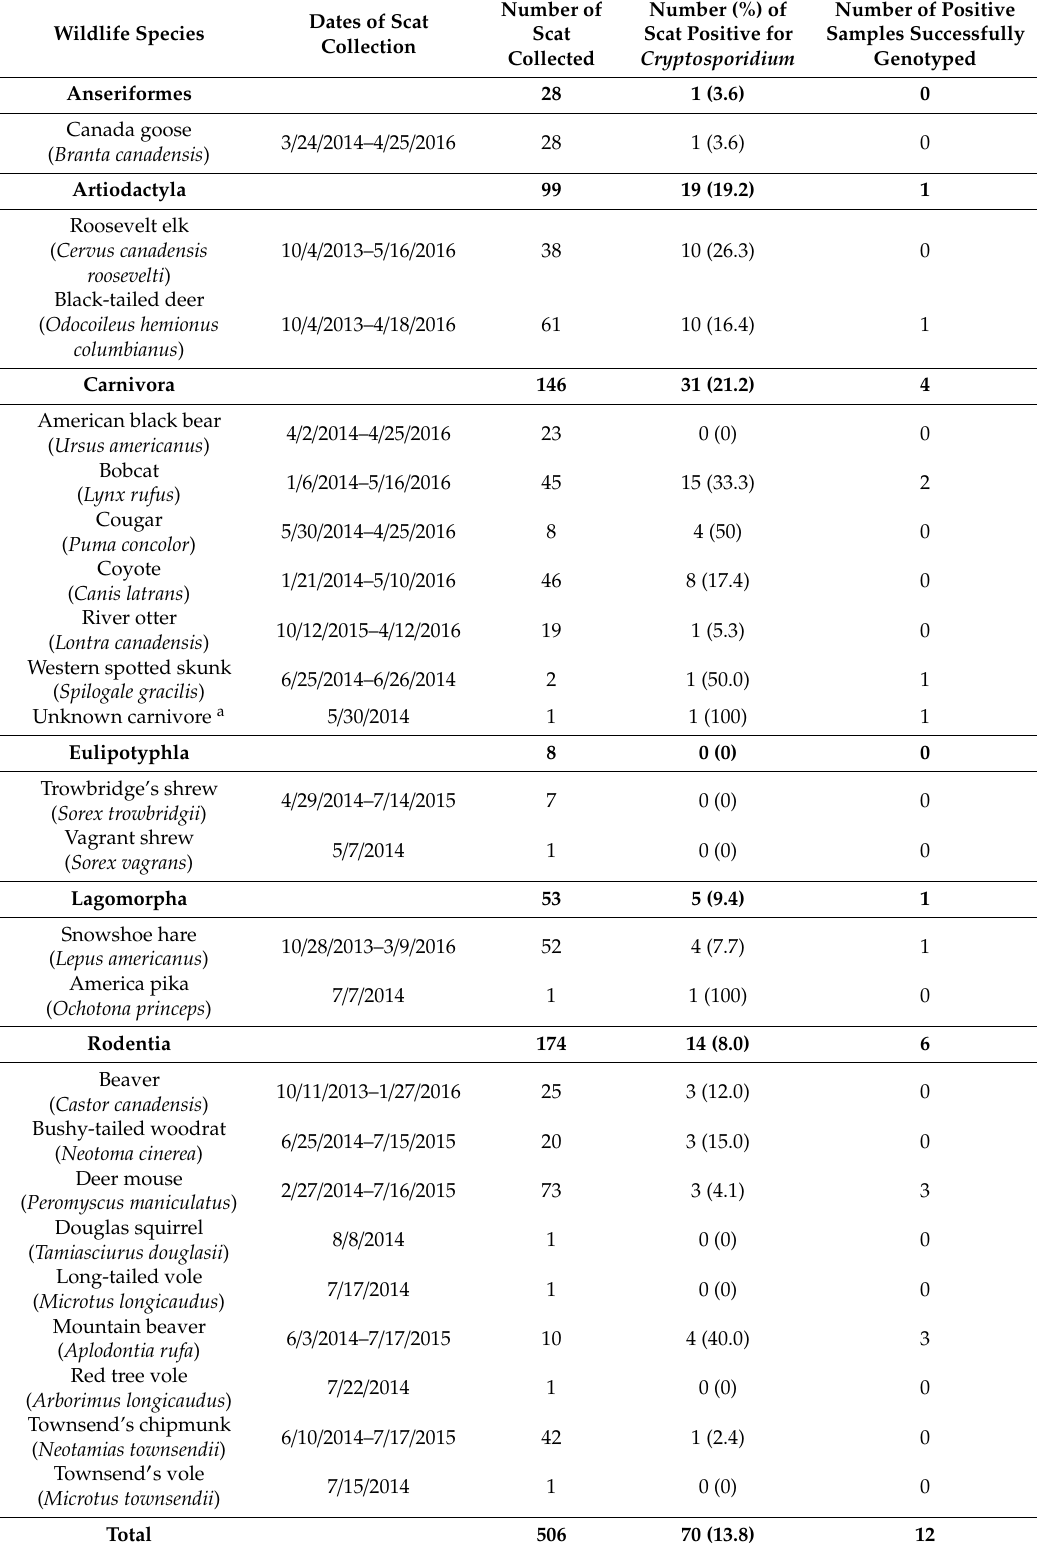
Table 2. Prevalence of Cryptosporidium in wildlife co-located on a protected watershed in the Pacific Northwest,